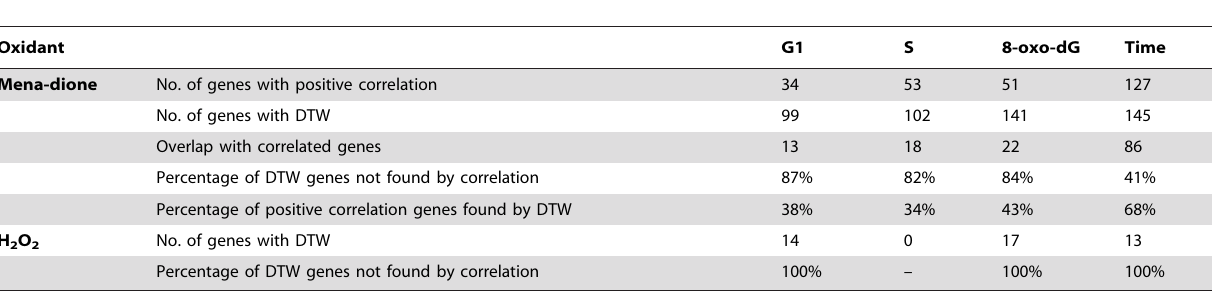
Table 1. Comparing DTW4Omics selected genes with correlation analysis.